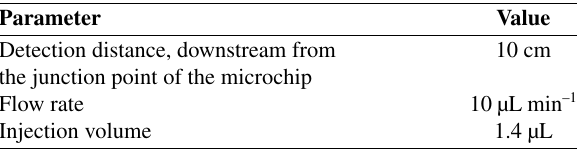
Table 2. The optimum conditions for the determination of Cr(VI) with DPC by μFIA–TLM (excitation wavelength, 514.5 nm; excita- tion power, 100